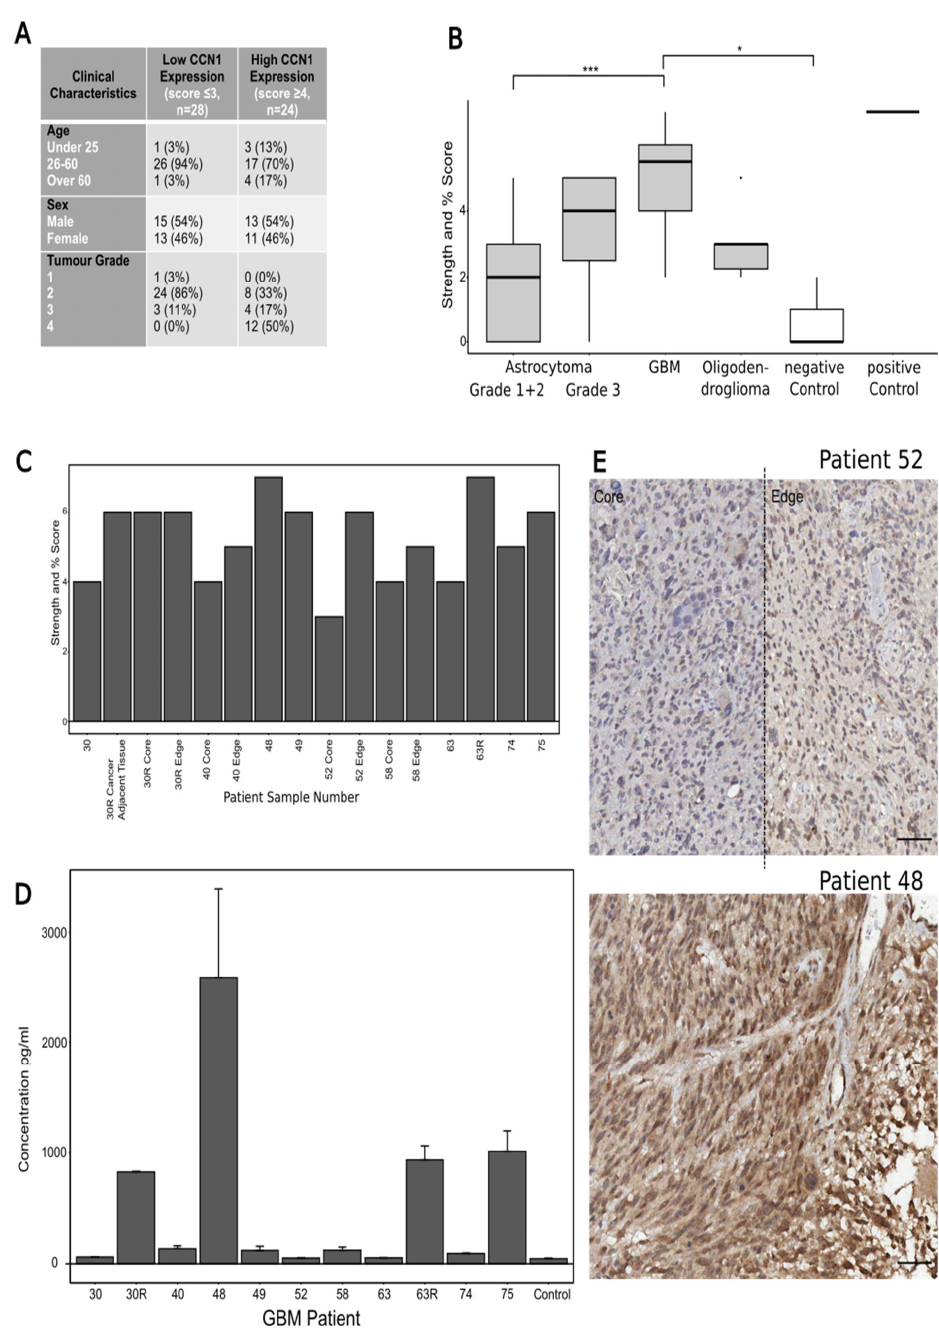
Figure 1. CCN1 expression in patient samples. ( A ) Combined scoring of CCN1 staining strength and percentage of the core covered on a TMA containing astrocytomas grade 1-2, GBM, oligoden- droglioma, cancer adjacent brain tissue as a control and an adrenal core as a positive control. ( B ) The clinical characteristics of the TMA astrocytoma samples. The results reveal associations of CCN1 expression levels with tumour grade. 86 % of the samples with low CCN1 expression are grade 2 astrocytomas, whilst 50% of the samples with high CCN1 expression are grade 4 astrocytomas (GBM). There were no associations of CCN1 levels with age or sex. ( C ) Combined scores of CCN1 staining intensity and percentage of staining covering the samples collected from 9 GBM patients during surgery. Recurrent tumour samples were also collected for patients 30 and 63 (30R and 63R). Samples of the core and edge of the tumour were collected for patients 30, 40, 52 and 58. Patient 30 also had a sample of cancer adjacent tissue collected. ( D ) CCN1 concentration in 9 patient blood serum